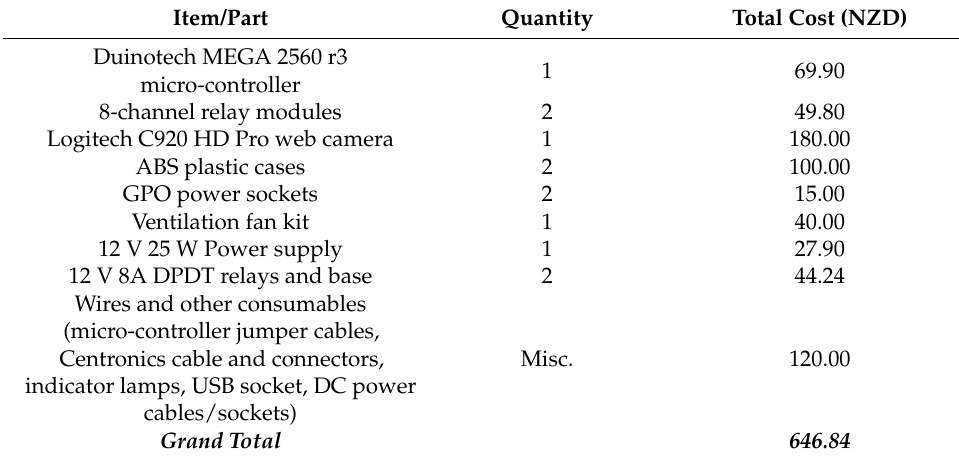
Table 2. Parts list and cost of remote laboratory